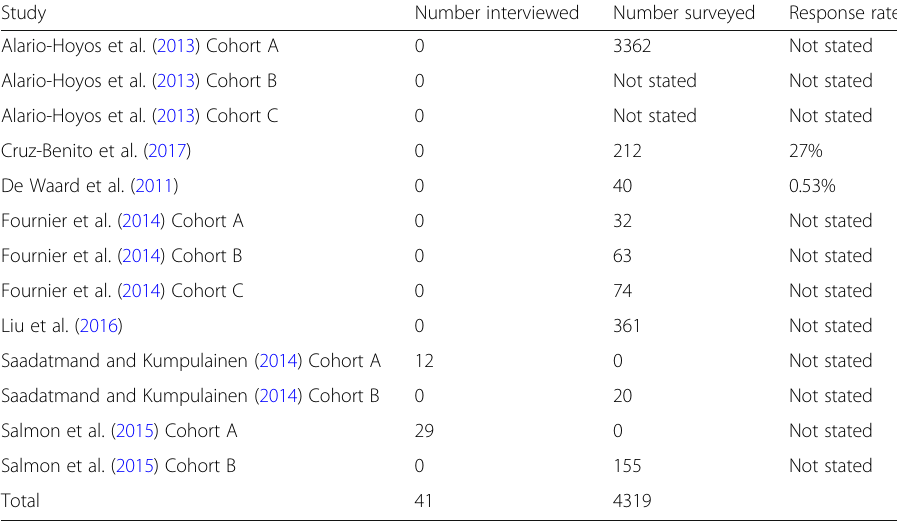
Table 4 Number of participants interviewed/surveyed